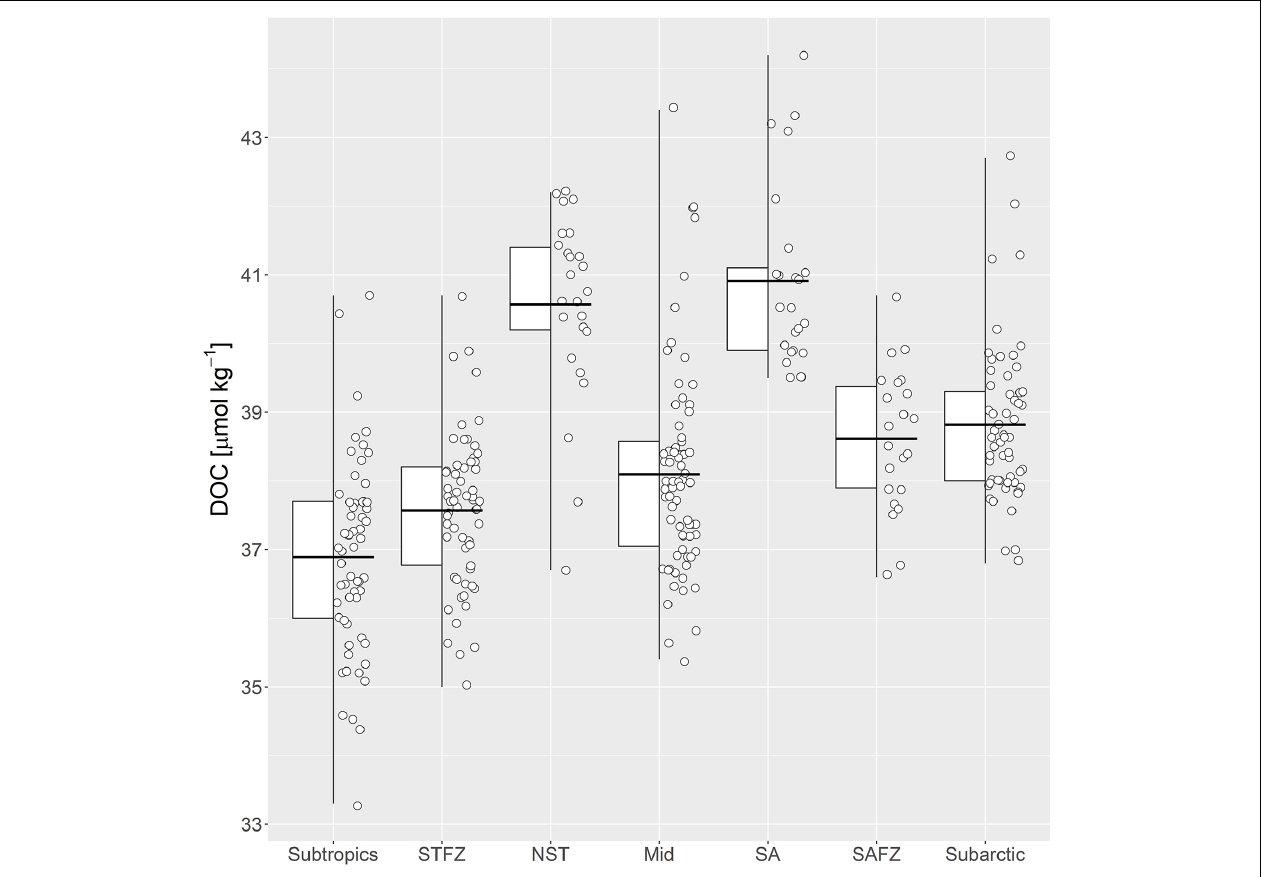
FIGURE 4 | Boxplot of DOC concentrations separated by frontal/non-frontal zones at depths > 1,000 m. Dots represent individual measurements within each zone, but their exact position on the x -axis is trivial. Whiskers represent the range of DOC concentrations. The lower and upper edges of the boxes represent the first and third quartiles of the data (i.e., 50% of the data lies within the box). The horizontal line represents the mean DOC concentration.